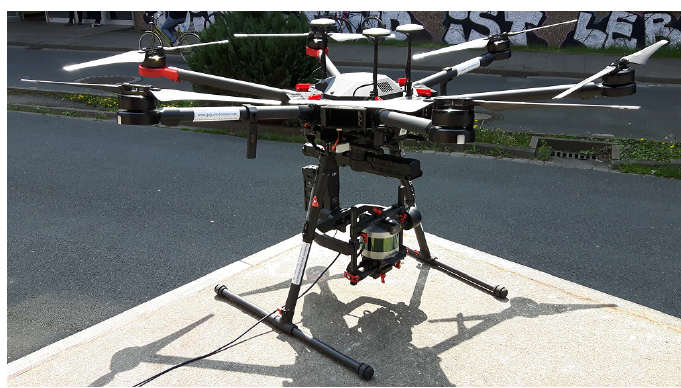
Figure 7. Overview of the prototype kinematic laser scanner-based UAV